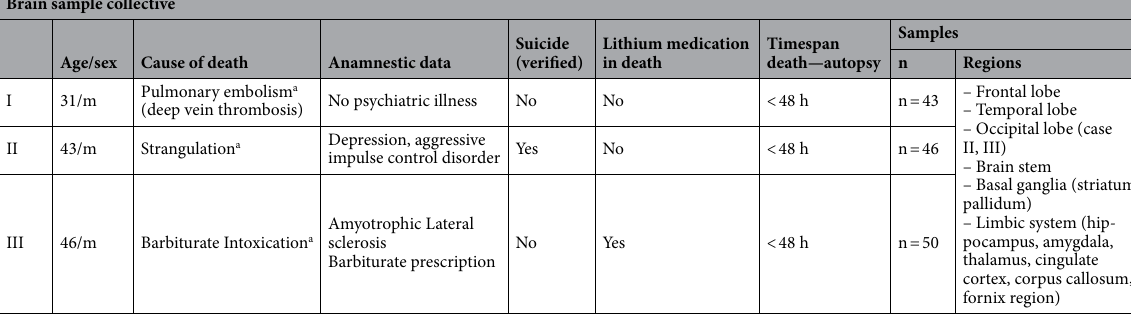
Table 1. Brain sample collective, n brain = 3, n samples = 139. a No pathomorphological signs of relevant brain edema, no macroscopic signs of degradation.